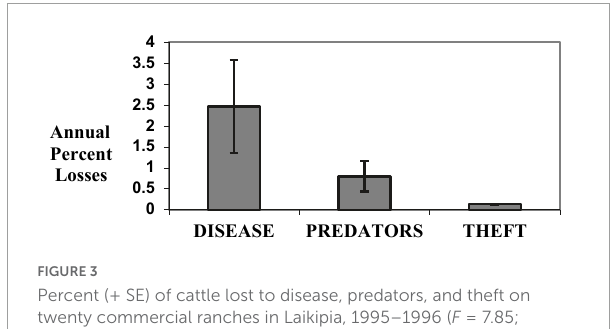
FIGURE3 Percent (+ SE) of cattle lost to disease, predators, and theft on twenty commercial ranches in Laikipia, 1995–1996 ( F = 7.85; df = 2.37; p =